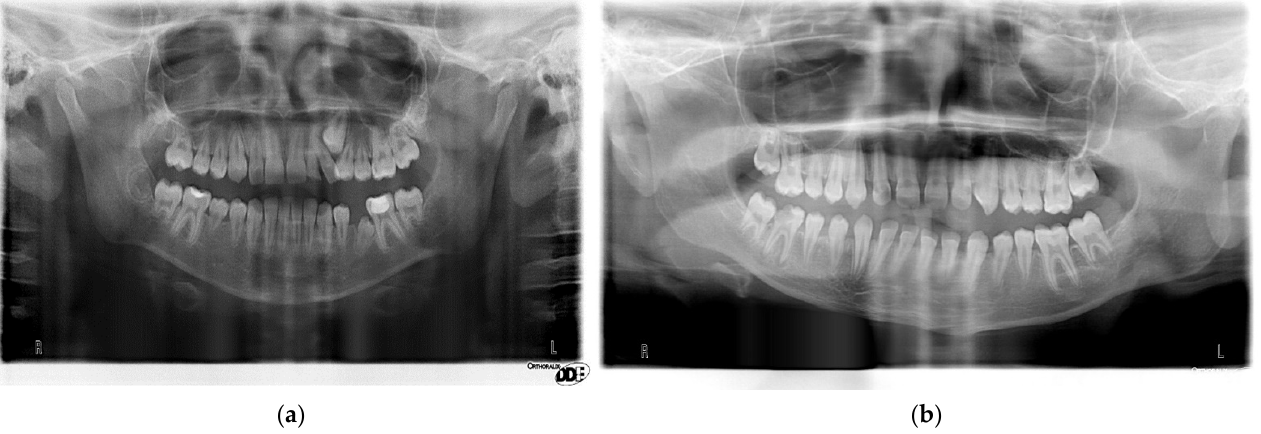
Figure 2. ( a ) Girl (cancer patient 1), aged 114 months, diagnosed with rhabdomyosarcoma (RMS) at the age of 57 months, treated for 36 months with CWS06-CEVAIE and TC protocols, with disease relapse, with posterior crossbite and persistent tooth 62, malformed roots and disturbed eruption of tooth 45; ( b ) Boy (cancer patient 2), aged 119 months, diagnosed with brain tumor at the age of 80 months, treated for 19 months with CZD II protocol and RTX of head, with anterior crossbite, spacing, and malformed roots.